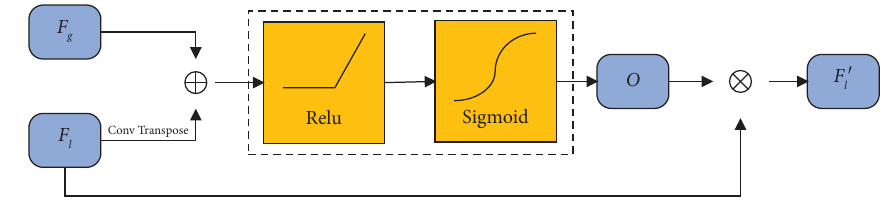
Figure 3: Attention module in prediction